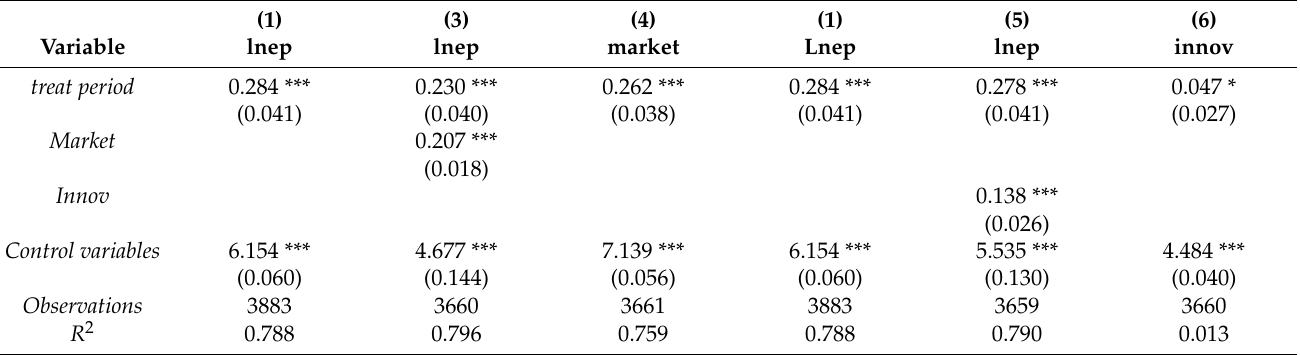
Table 8. Impact mechanism test: Marketization level and technological innovation perspective